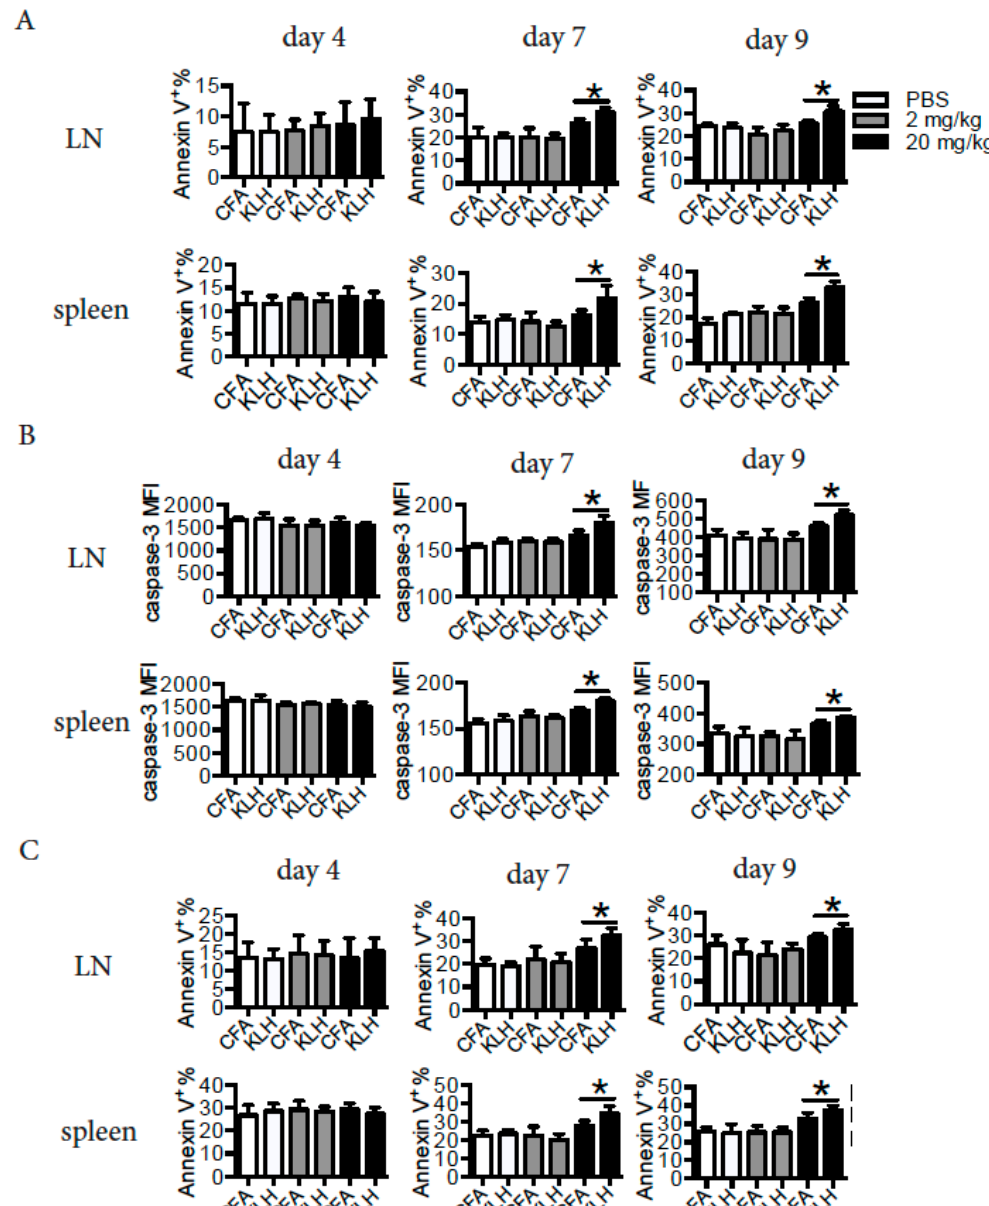
Figure 3. PQ induced apoptosis of CD4 T cells or B cells at late stage, but not at early stage during the primary immune response to KLH. B6 mice treated with PQ for 2 wks were immunized with KLH at day 4 post the initial PQ treatment. Apoptosis of CD4 T cells (CD3 + CD4 + ) and B cells (CD19 + ) in the LN and spleen were evaluated at day 4, 7, and 9 post the KLH immunization, respectively. ( A ) Surface expression of Annexin V on CD4 T cells. ( B ) Intracellular cleaved (active) caspase-3 expression in CD4 T cells. ( C ) Surface expression of Annexin V on B cells. A total of 6 mice were used for each group. Asterisk represents a significant di ff erence between groups as